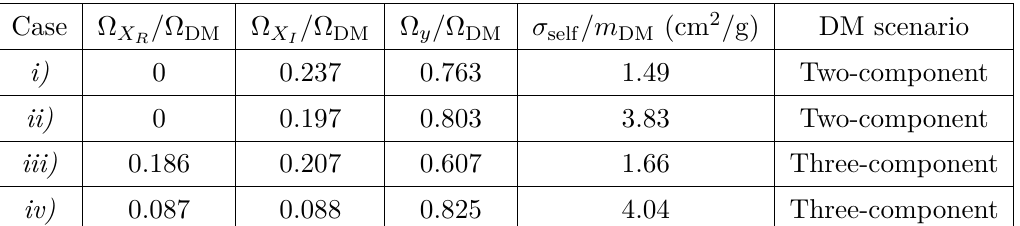
Table 2 . The fractions of relic density for each DM candidate field and the self-scattering cross sec- tions are shown for the four benchmark cases. The input parameters are summarised in table 1. The total DM relic density is Ω 2 = 0 . 12 . As expected from the mass gap between X DM h i) and ii) give rise to two-component DM scenarios, while three-component DM scenarios are